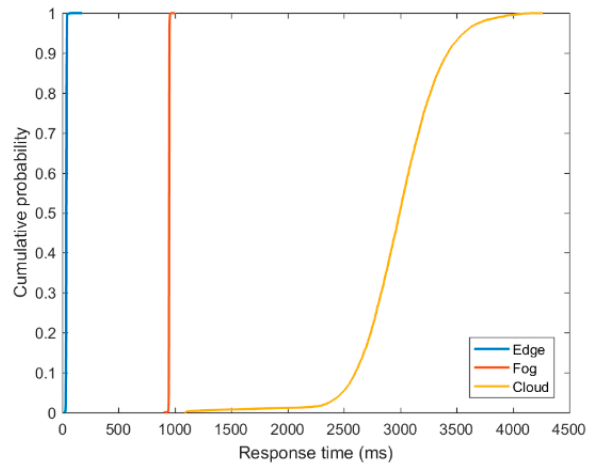
Figure 12. CDF of response time offered by the Edge, Fog and Cloud infrastructures.